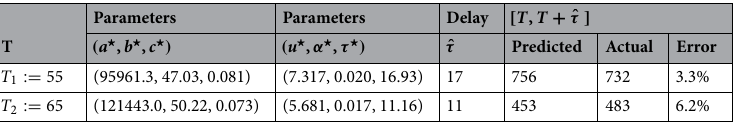
Table 1. Optimal parameters for the logistic growth model function (cid:31) and for the model function ϕ of delayed deaths (4), using training data ( t i , n i , d i ) , i = 1, . . . , T with T = T 1 := 55 and T = T 2 := 65 , and the comparison between the numbers of predicted and of actual deaths in the period [ T , T + ˆ τ ]